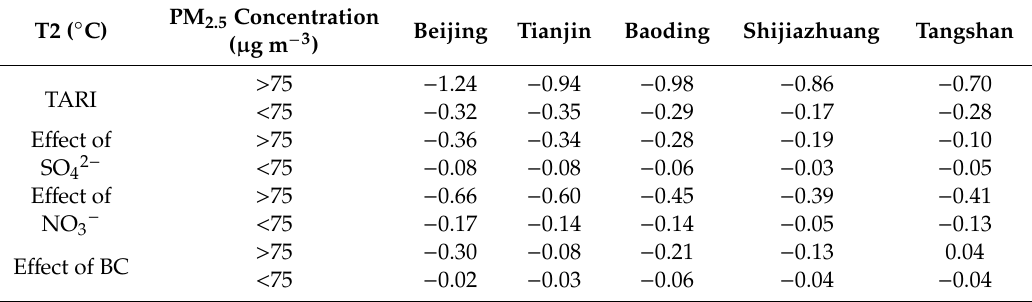
Table 5. The e ff ect on T2 under di ff erent PM 2.5 pollution levels.